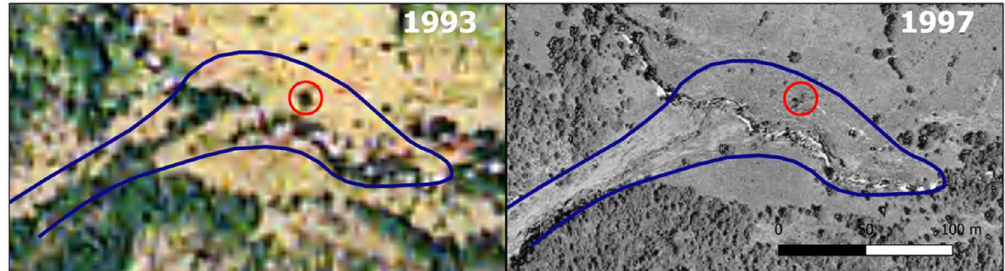
Figure 8. Comparison of prior-to-the-event (1993) and post-event (1997) orthoimages of the avalanche that occurred in the winter of 1995–96. Forest loss and surficial effects on terrain are clearly visible in 1997 image. The red circle indicates the position of tree 17 in Figure 11 (picture in Figure 4c).